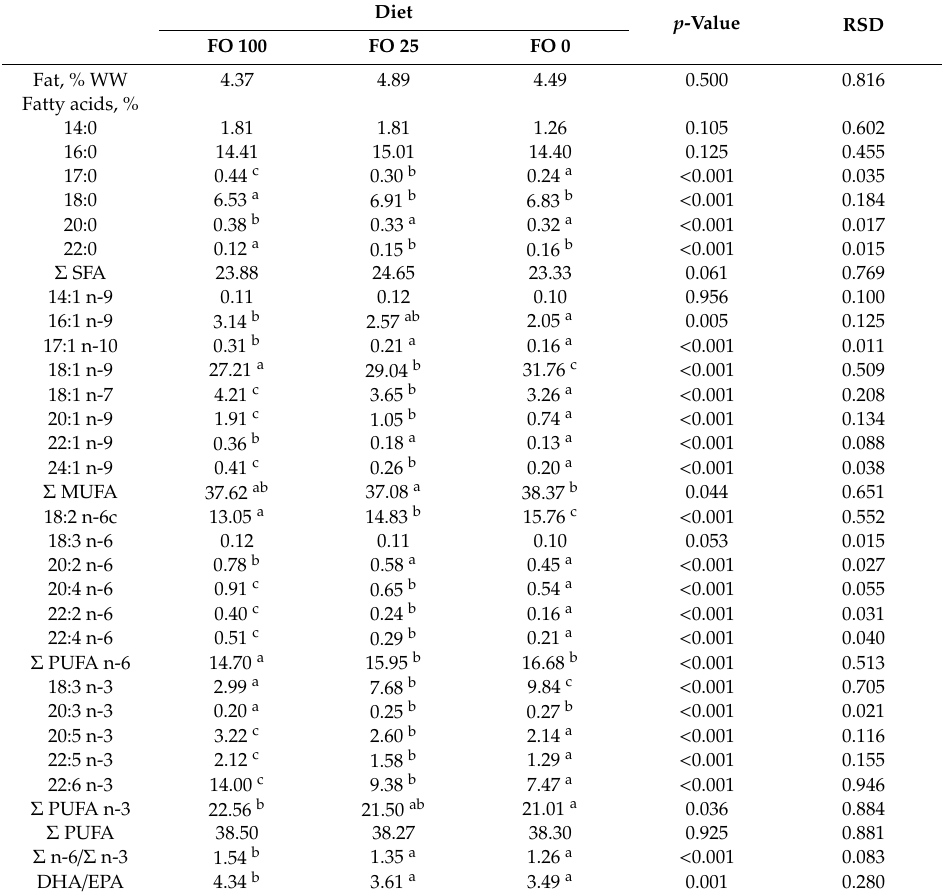
Table 6. Fat content and fatty acid composition (% of total fatty acid content) of the red muscle in Mediterranean yellowtails fed the experimental diets ( n = 12 per diet). Values are expressed as LS